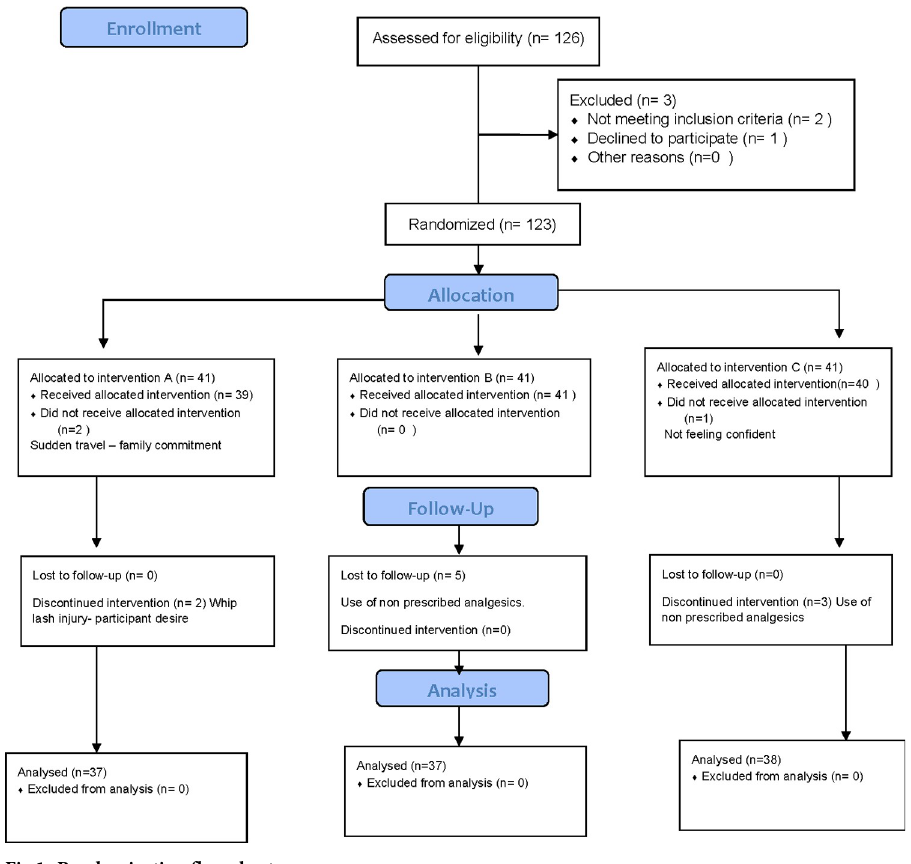
Fig 1. Randomization flow